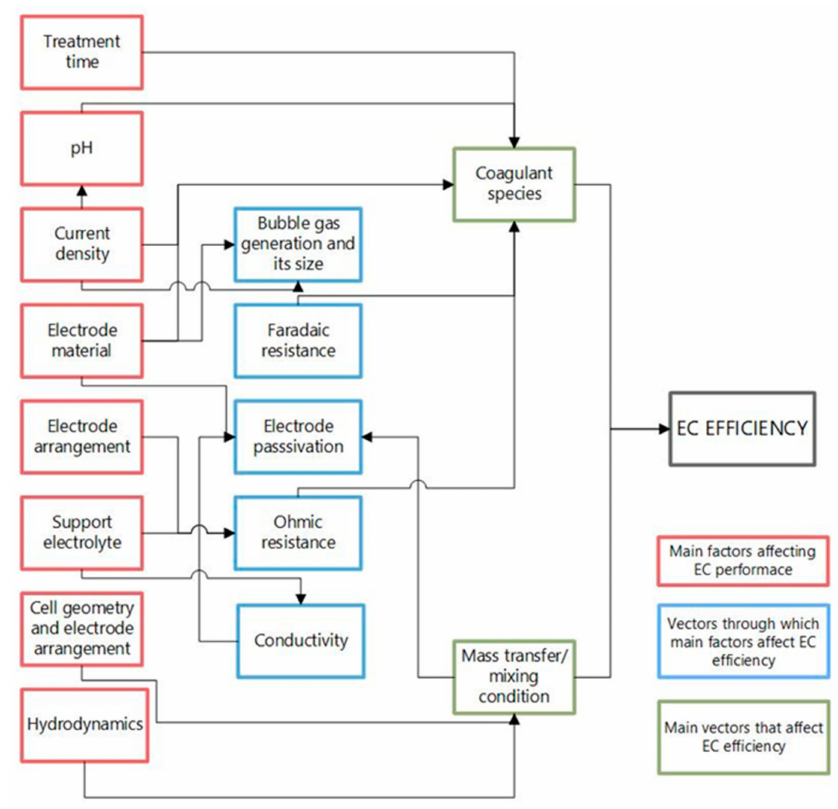
Figure 3. Main factors affecting the EC process (Modified Hakizimana et al.